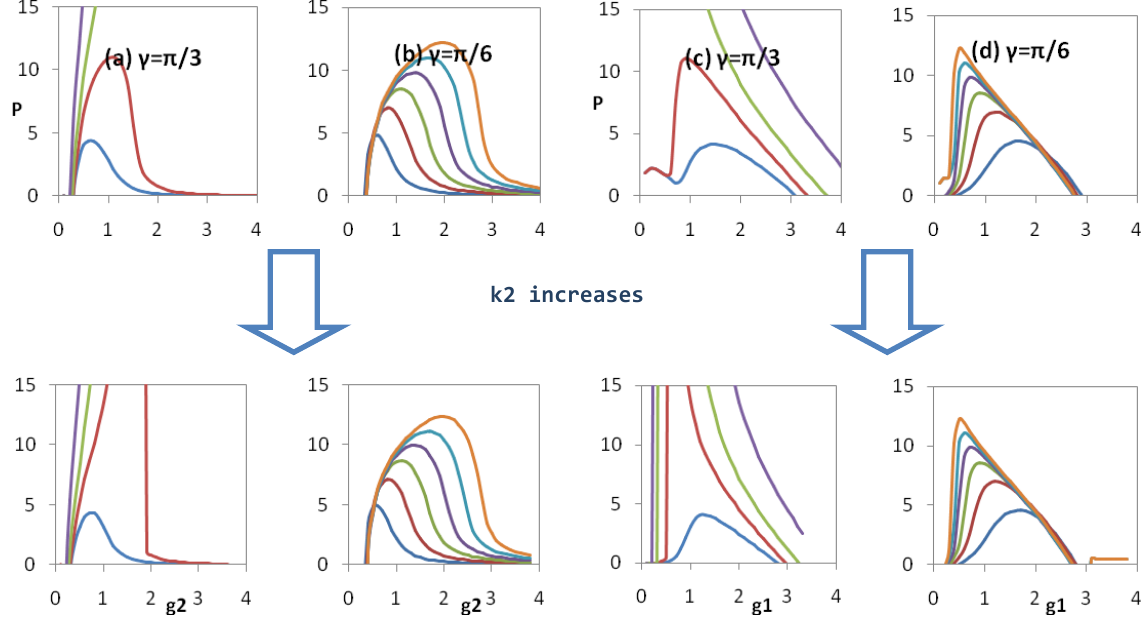
Figure 7: Effects of changing fiber strength. One-layer model. µ =5kPa; k 1 =1.0; A=0.5, B=1.0. Zero normal and shear stress boundary condi- tion. Critical buckling pressure plotted against g 1 or g 2 . First row, k 2 = 0.2; second row:k 2